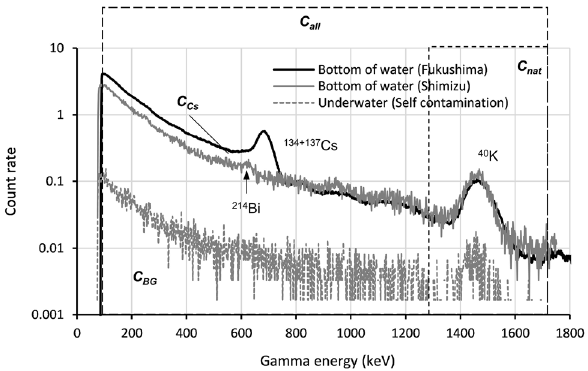
Figure 7. Gamma spectrum of the towed radiation survey system and the setting of the region of interest. The measurement time of this spectrum was 600–1200